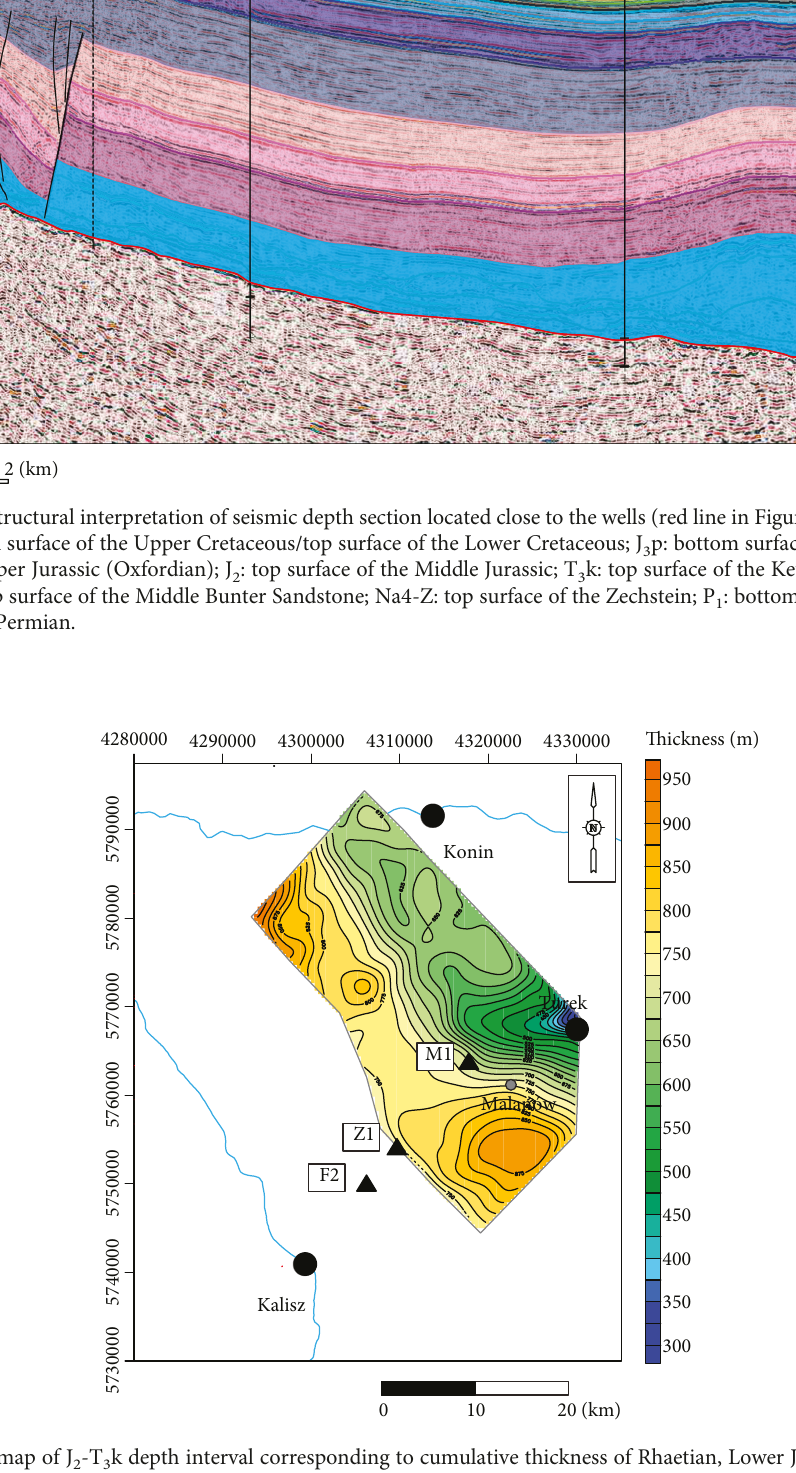
-T k depth interval corresponding to cumulative thickness of Rhaetian, Lower Jurassic, and Middle Jurassic. 2 3